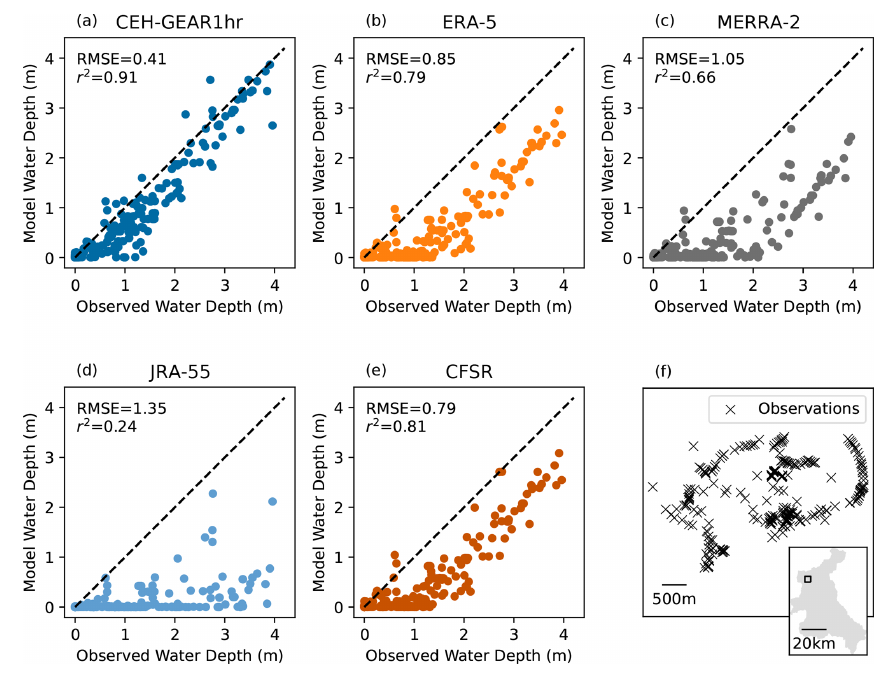
Figure 6. Panels (a–e) show a comparison of modelled and observed water depths from wrack and water marks in Carlisle during the 2005 event (Neal et al., 2009). Panel (f) shows the locations at which the water depths were measured.